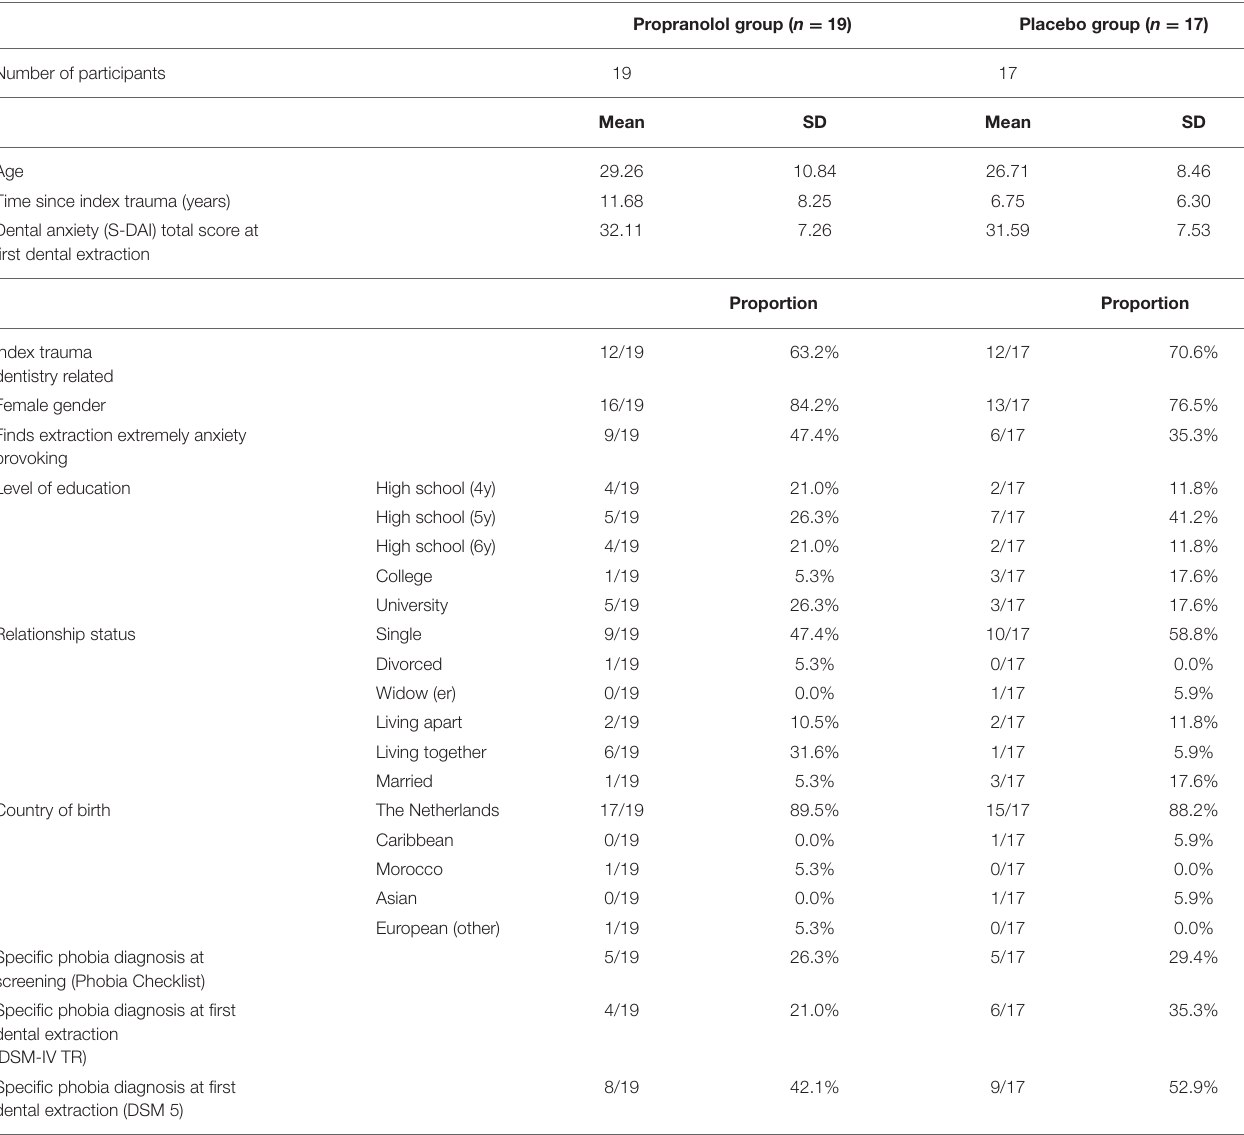
TABLE 1 | Baseline demographic and clinical characteristics of patients assigned to the propranolol and placebo